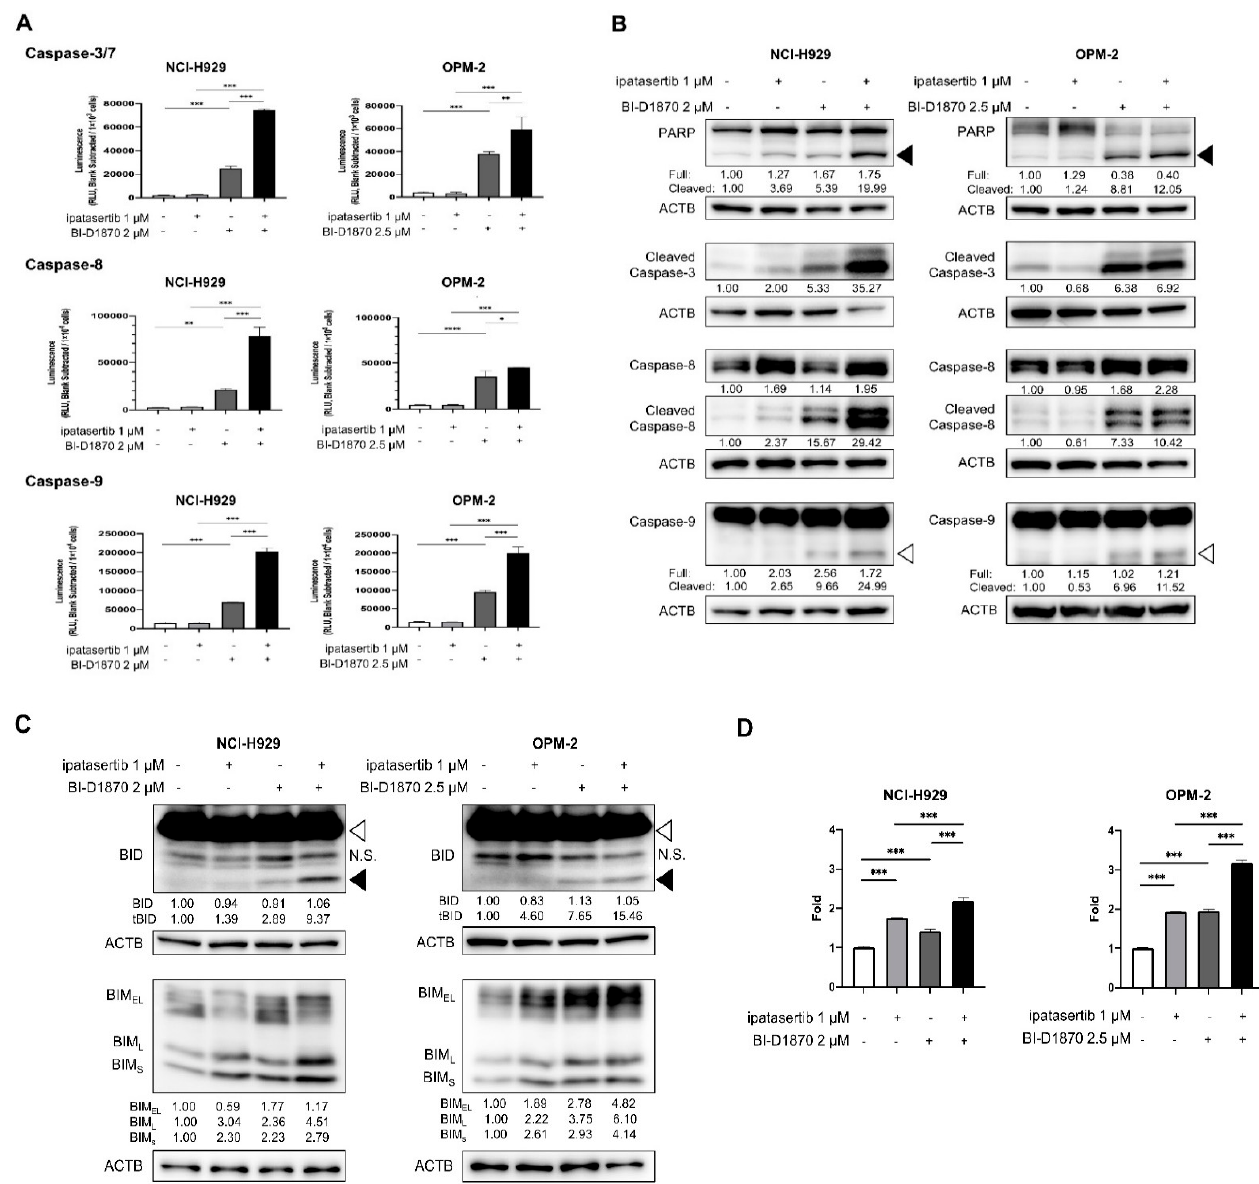
Figure 3. Molecular effects with apoptotic induction by BI-D1870, ipatasertib, and their combination: Cells were seeded at 2 × 10 5 cells/mL and treated with indicated concentrations of BI-D1870, ipatasertib, or both agents for 48 h. ( A ) Activities of Caspase-3/7, Caspase-8, and Caspase-9 of untreated and treated cells measured by Caspase-Glo assay systems. ( B ) WB analyses for the detection of processing of caspases and PARP. Black arrow head and white arrow head indicate cleaved form of PARP and cleaved form of Caspase-9, respectively. ( C ) WB analysis for the detection of the activation of BID and the induction of BIM in untreated and treated HMCLs. White arrow head and black arrow head indicate full length BID and truncated BID, respectively. N.S.; no specific band. Expression levels relative to control (untreated cells) are shown below each band measured by densitometric analysis using Image-J software. ACTB was used as an internal control. ( D ) Transcriptional levels of BIM in treated cells relative to untreated cells. Mean value with S.D. of triplicate data. * p < 0.05, ** p < 0.01 *** p < 0.001, **** p < 0.0001.